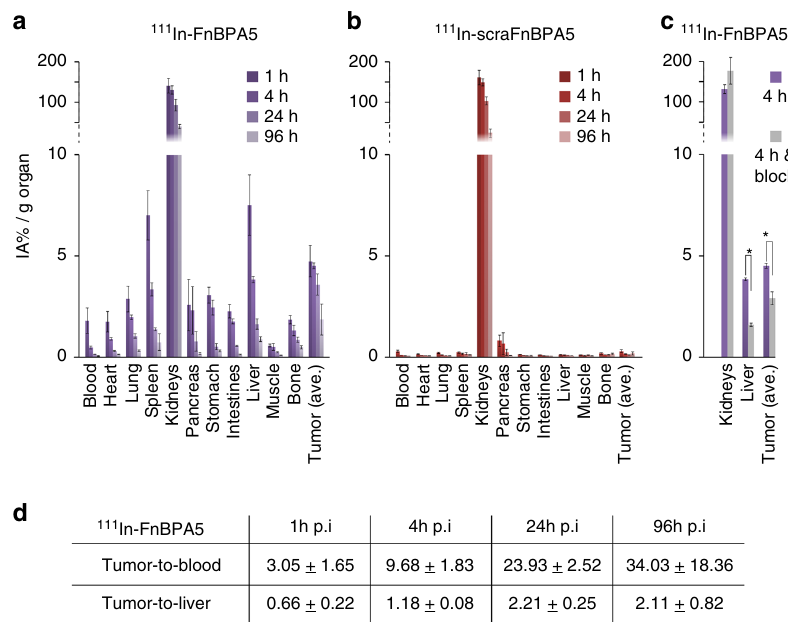
Fig. 6 Biodistribution and blocking study of radiolabeled 111 In-FnBPA5 and 111 In-scraFnBPA5. a The biodistribution of 111 In-FnBPA5 in PC-3-bearing mice was monitored at different time points in various organs. b The biodistribution of 111 In-scraFnBPA5 was monitored in the same way. 111 In-FnBPA5 (violet) showed a signi fi cant higher uptake than 111 In-scraFnBPA5 (red) in all organs except for the kidneys, con fi rming the Fn-speci fi city of the accumulation. c Blocking studies were performed and the uptake was analyzed 4 h post injection (p.i.). The blocking of the binding sites via the pre-injection of unlabeled FnBPA5 caused a signi fi cant reduction in the uptake of 111 In-FnBPA5 in both liver and tumor (* p < 0.05, Student ’ s t test, n = 4), whereas it did not change the uptake in the kidneys. The blocking showed a higher in fl uence on 111 In-FnBPA5 uptake in the liver than in the tumor, suggesting the presence of more binding sites ( fi bronectin) in the tumor. d The higher retention time of 111 In-FnBPA5 in the tumor is re fl ected in increasing tumor-to-blood and tumor-to- liver ratios with increasing time. Bars represent means with error bars being standard